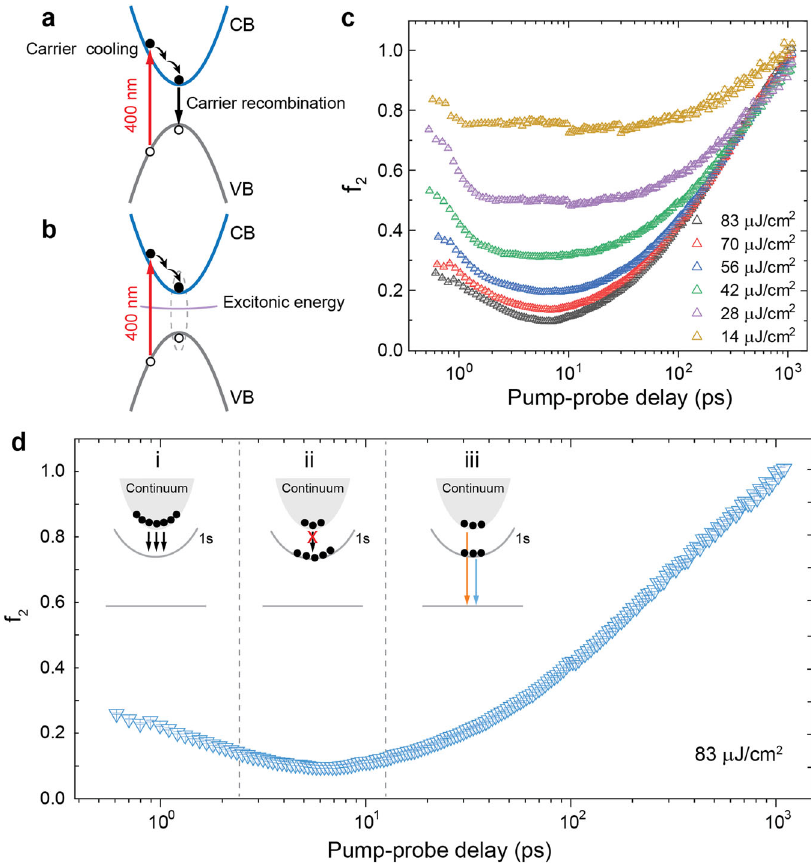
Fig. 6 Fate of photogenerated carriers. Two possible paths of carriers to a recombine with holes in the valence band, involving (or without involving) a third carrier, and b bind with holes, forming excitons in the excitonic levels. CB and VB mean conduction band and valence band, respectively. c The time evolution of f 2 at different pump fl uences. d The f 2 evolution for 83 μ J/cm 2 . The inset illustrates three stages of relaxation between the free carrier band (continuum) and the exciton level (1s level) (denoted by black arrows). The red ''X ” denotes the transition has been forbidden because of excitonic state- fi lling effect. The orange and blue arrows denote the carrier recombination and exciton decay, respectively. Errors of f 2 are standard error that is determined by calculating the 95% con fi dence interval, based on residual values and Jacobian matrix obtained from the fi ts to Eq.